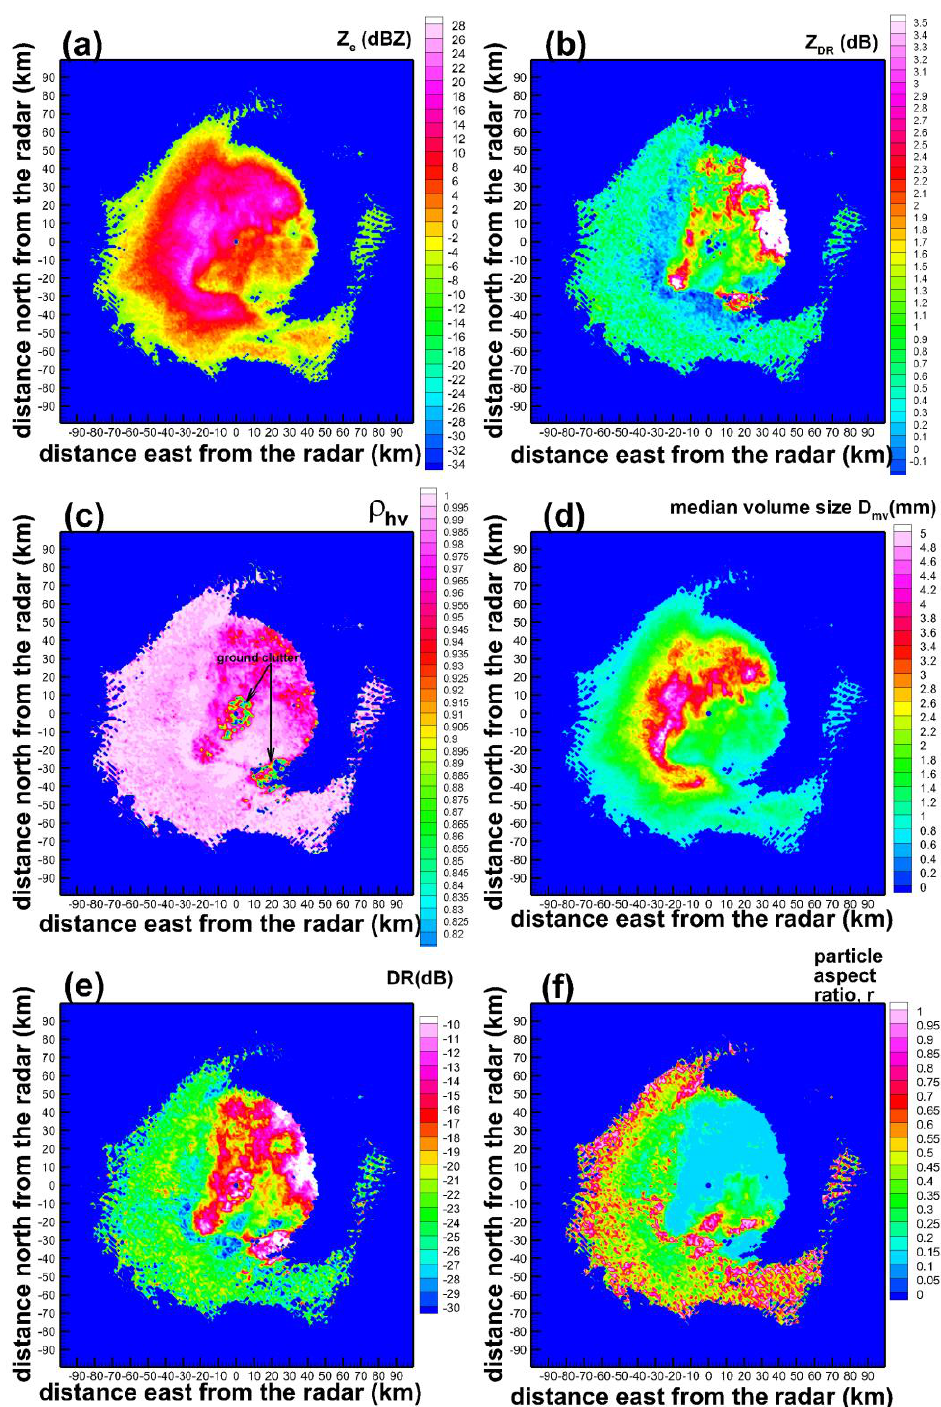
Figure 6. Measurements of horizontal polarization reflectivity ( a ), differential reflectivity ( b ), copolar correlation coefficient ( c ), estimates of depolarization ratio ( e ) and retrievals of particle median volume size ( d ) and aspect ratio ( f ) corresponding to a KDLH radar scan at 4.5° on 20 February 2014 at 19:31 UTC.